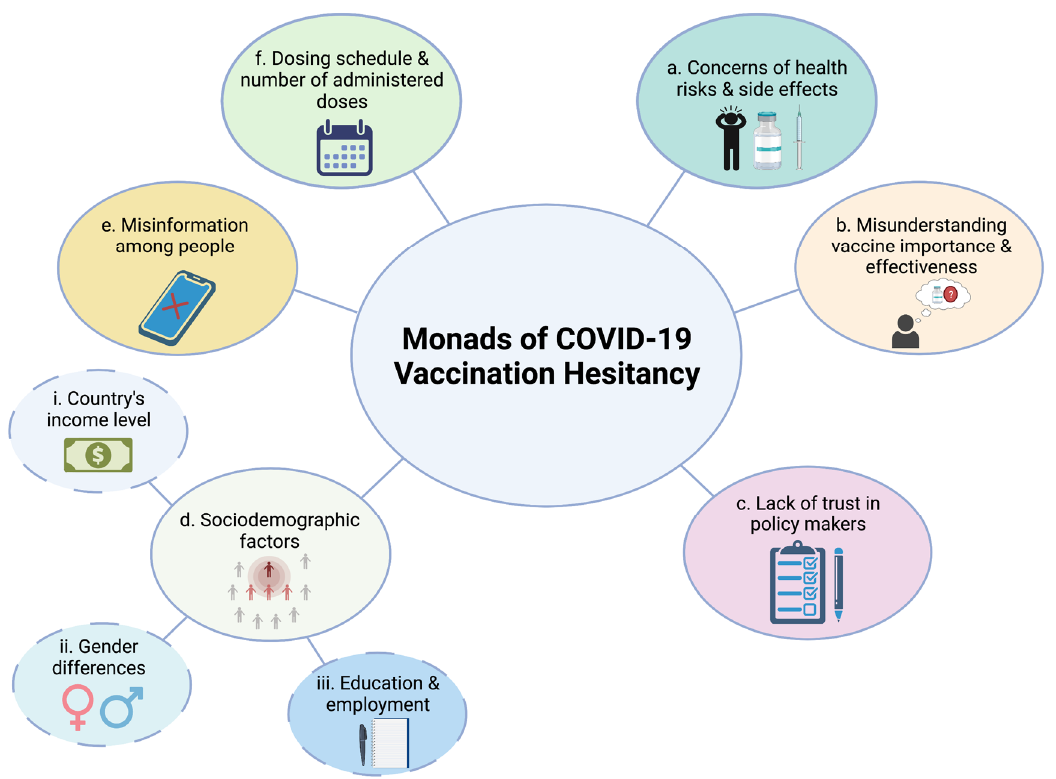
Figure 2. The Monads of COVID-19 vaccination hesitancy. ( a ) Apprehension due to presumed health risks and inaccurate knowledge regarding the vaccine’s side effects. ( b ) Improper understanding of the importance and effectiveness of the vaccine. ( c ) Lack of trust in policy makers. ( d ) Sociodemographic factors attributing to variations in vaccine acceptance rates including ( i ) country’s income level, ( ii ) gender differences, and ( iii ) education level and employment status. ( e ) Inaccurate and incomplete information about vaccines provided to the public. ( f ) Dosing schedule and the number of administered doses. The figure was created with BioRender.com.